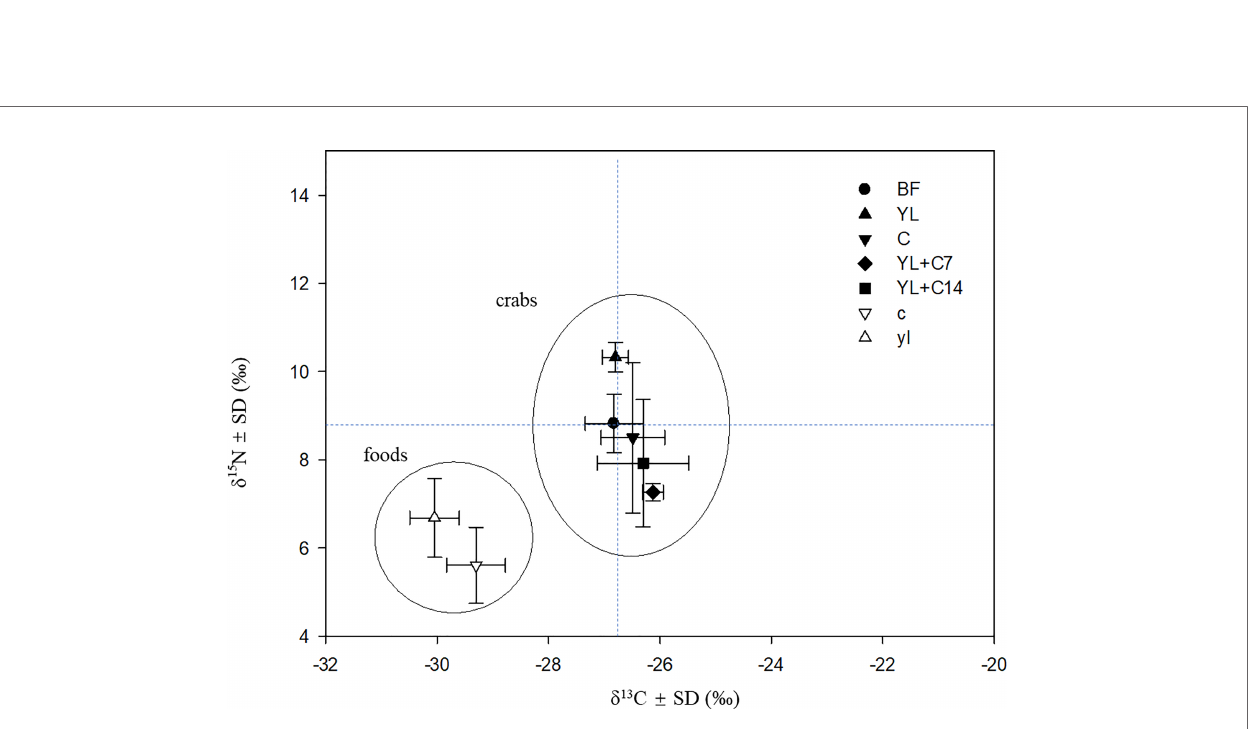
FIGURE 4 | Variations in d 13 C and d 15 N values (both individual and mean ± SD values) of muscle tissues of crabs fed 13 C- and 15 N-enriched foods in two different treatments (T1, 13 C-enriched leaf + 15 N-enriched MPB; T2, 13 C-enriched MPB + 15 N-enriched leaf) over the four-week experiment (W1-W4). The dash lines indicate the enrichment level of the respective food sources.